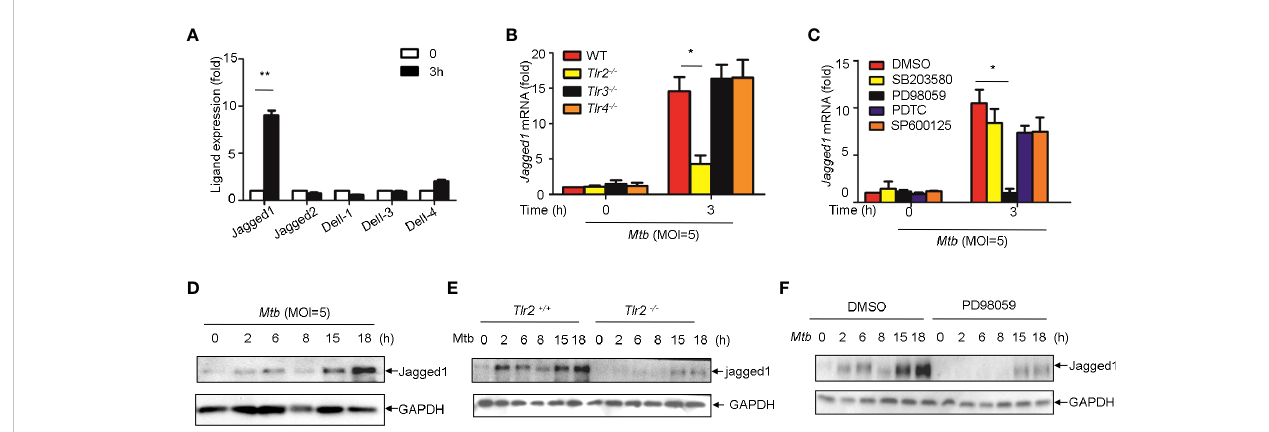
FIGURE 6 Mtb up-regulate Jagged1 expression in macrophage via TLR2-triggered ERK signaling. (A) qRT-PCR detection of different Notch ligands expression in Mtb -infected peritoneal macrophages. (B) qRT-PCR detection of Jagged1 mRNA in WT, Tlr2 -/- , Tlr3 -/- , Tlr4 -/- macrophages infected with Mtb for 3h. (C) qRT-PCR detection of Jagged1 mRNA in Mtb -infected mice peritoneal macrophages pretreated with ERK inhibitor PD98059 (10 uM), NF- k b inhibitor PDTC (10uM), JNK inhibitor SP600125 (10uM) and p38 inhibitor SB203580(10uM) for 1 (h) (D) IB detection of Jagged1 in Mtb -infected macrophages. (E) IB detection of Jagged1 expression in peritoneal macrophages of WT or Tlr2 -/- mice infected with Mtb for indicated times. (F) IB detection of Jagged1 in Mtb -infected macrophages treated as in (C, G) Diagram of Notch4 and jagged1 expression. MOI=5. Data shown in (A-C) are Mean ± SEM and the representative of three independent experiments. * P < 0.05, ** P < 0.01 by the Student ’ s t test. Data in (D-F) were representative of three independent experiments.